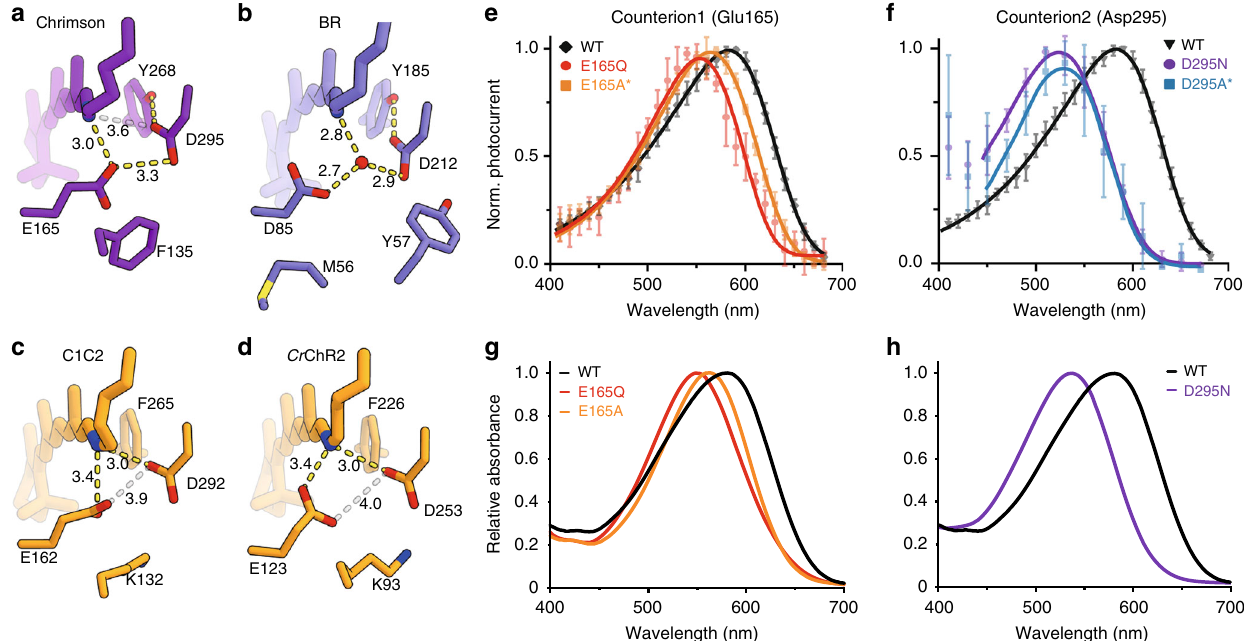
Fig. 3 Counterion con fi guration of Chrimson and adjacent residues. a – d Hydrogen-bonding interactions around the protonated Schiff base are shown for Chrimson ( a ), BR ( b ), C1C2 ( c ), and Cr ChR2 ( d ). Proposed hydrogen-bonding interactions are indicated by yellow dotted lines, and additional possible interactions with longer distances are indicated by gray lines, with the distance (Å) indicated beside each line. e – h action ( e , f ) and absorption ( g , h ) spectra of the counterion residue mutants (Action spectra represent Mean± SD; n = 5 – 7; symmetric 110 mM NaCl, pH e,i 7.2 and − 60 mV. Datasets indicated by asterisk are quoted from a previous study 22 . Same mutants are indicated by the same color codes. The fi tted curves for the D295N and D295A action spectra were adjusted to the photocurrents activated by light of 440 nm or higher wavelength. Absorption spectrum of the D295A mutant could not be measured, due to its instability in the detergent solubilized form, and thus is not included in the panel ( h